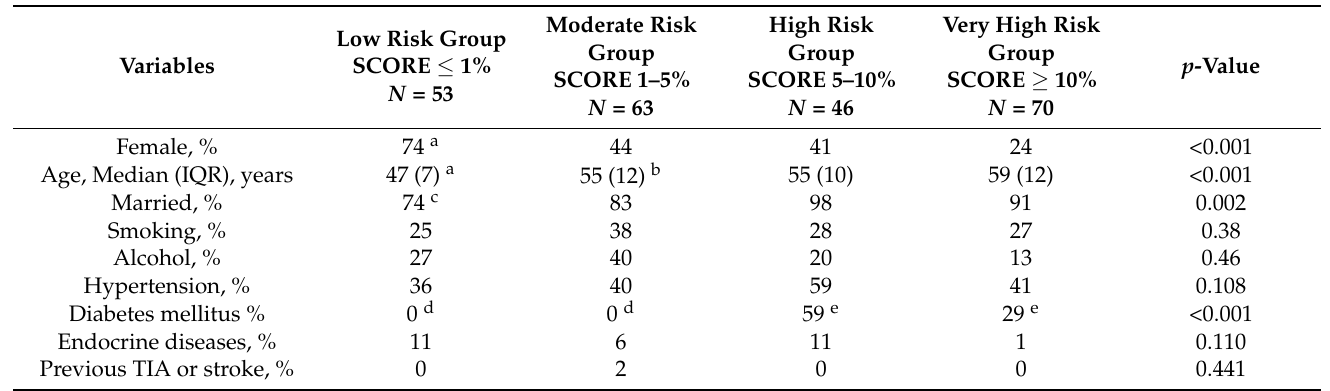
Table 1. Demographic and Clinical Characteristics of the Patients at Baseline.